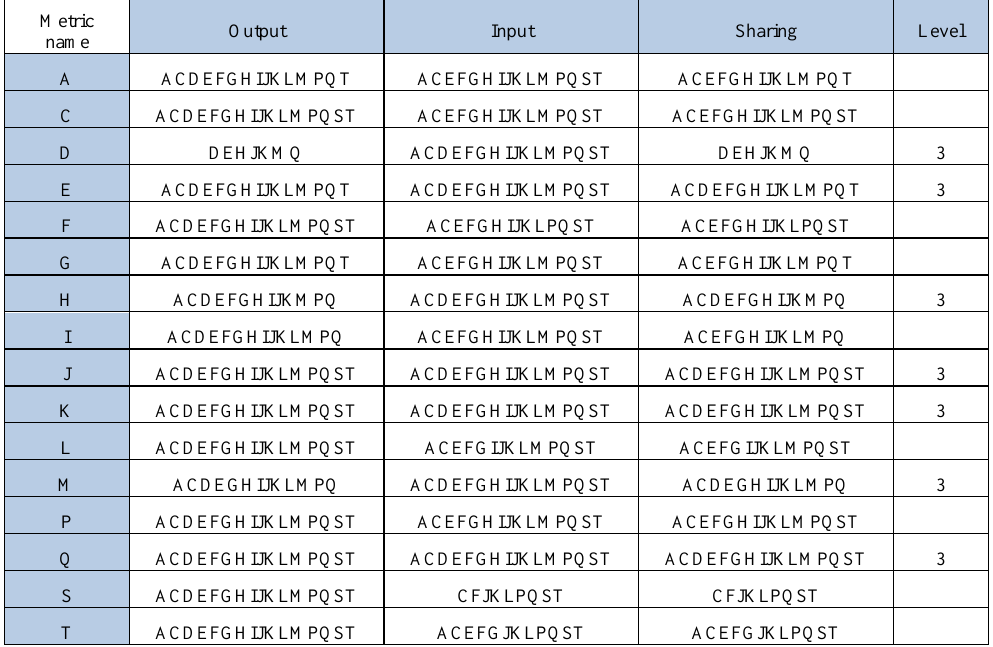
Table 6: Level 3